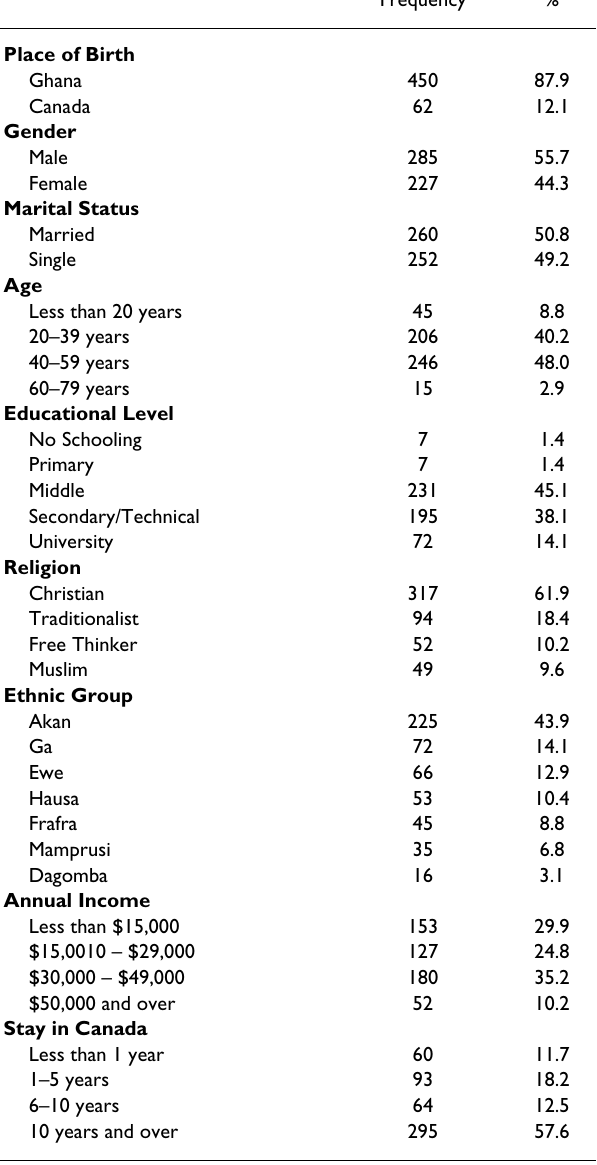
Table 1: Demographic information (n = 512)